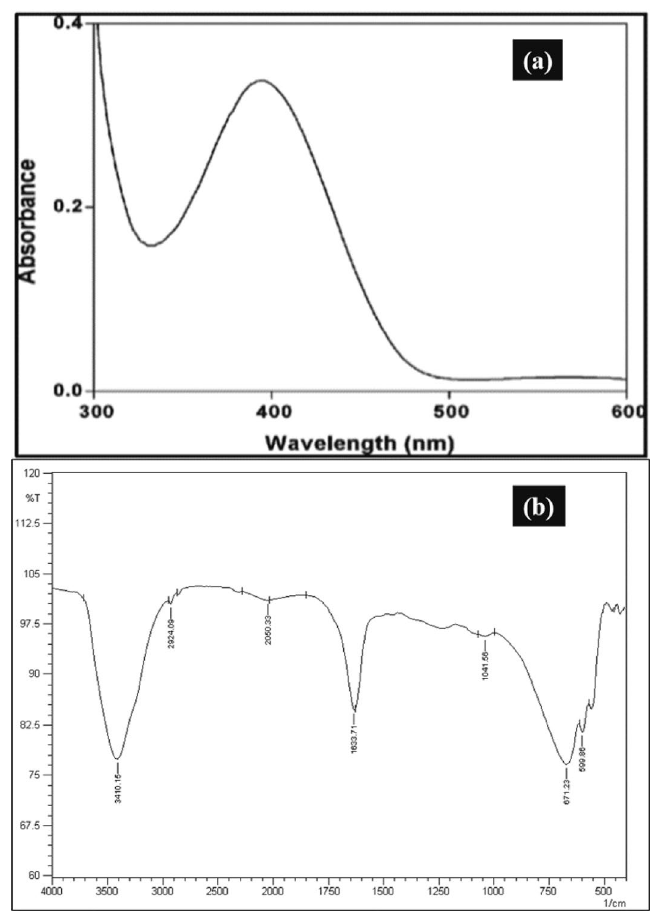
Figure 6. The UV–VIS ( a ) and FTIR ( b ) spectrum of the Green Iron-nanoparticles. ( a ) The absorbance of Green Iron-nanoparticles was maximum at 395 nm and that range confirms the presence of Fe–Cl complex within the sample 16 . ( b ) The FTIR spectrum of nanoparticles indicates the presence of bands at 3410, 2924, 2050, 1633, 1041, 671, and 599 cm −1